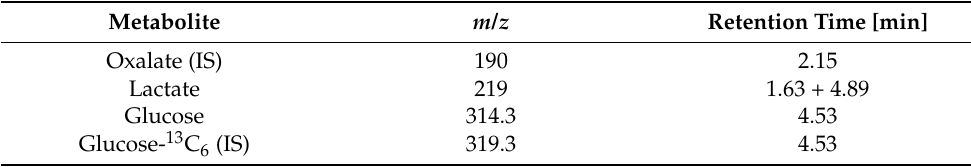
Table 3. Retention times and characteristic mass/charge of analyzed